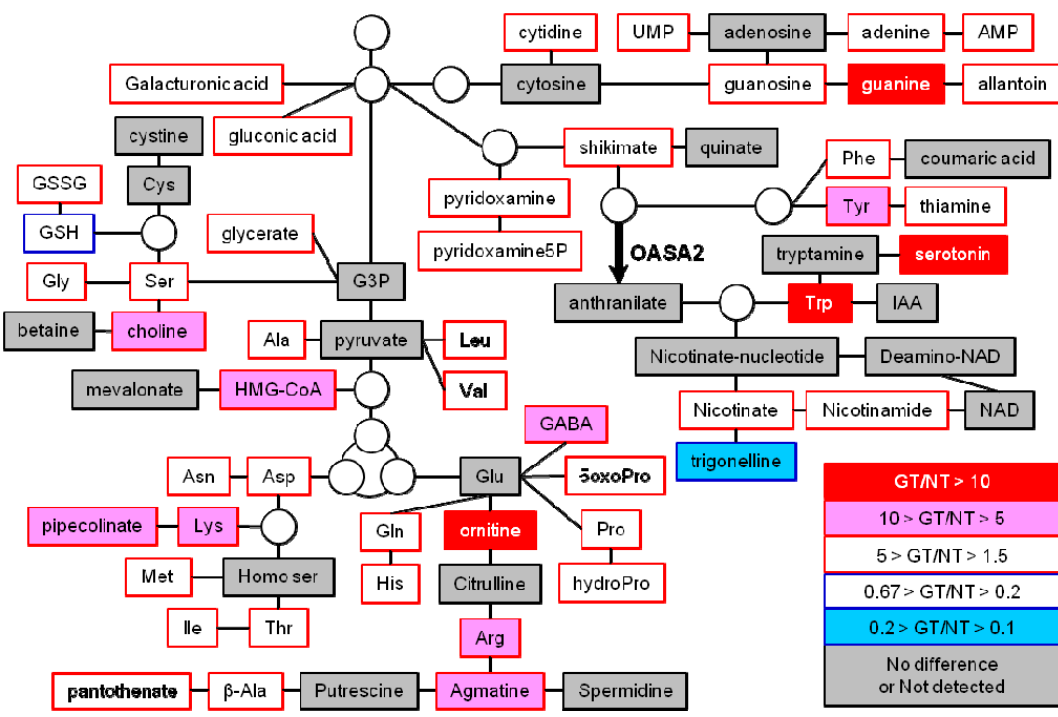
Figure 4. Changes in metabolite levels derived from amino acids in mature seeds. Mature seeds of non-transformant (NT) and homozygous GT plants (GT) were subjected to metabolome analysis using CE-MS (see Tables S1–S3). Representative metabolites are shown in this pathway map, and the fold change in metabolite levels in mature seeds of GT plants to that in NT is shown using a color scale, as